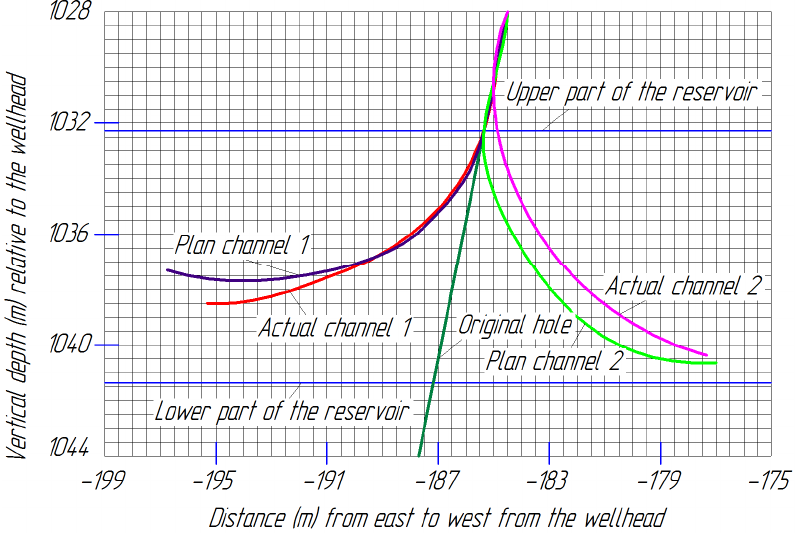
Figure 7. Drilled channel trajectories (side view) based on data from the gyroscope, “TWIN GYRO”, (No. 1 in red) and the inclinometer, “KVARTS-36” (No. 2 in purple).